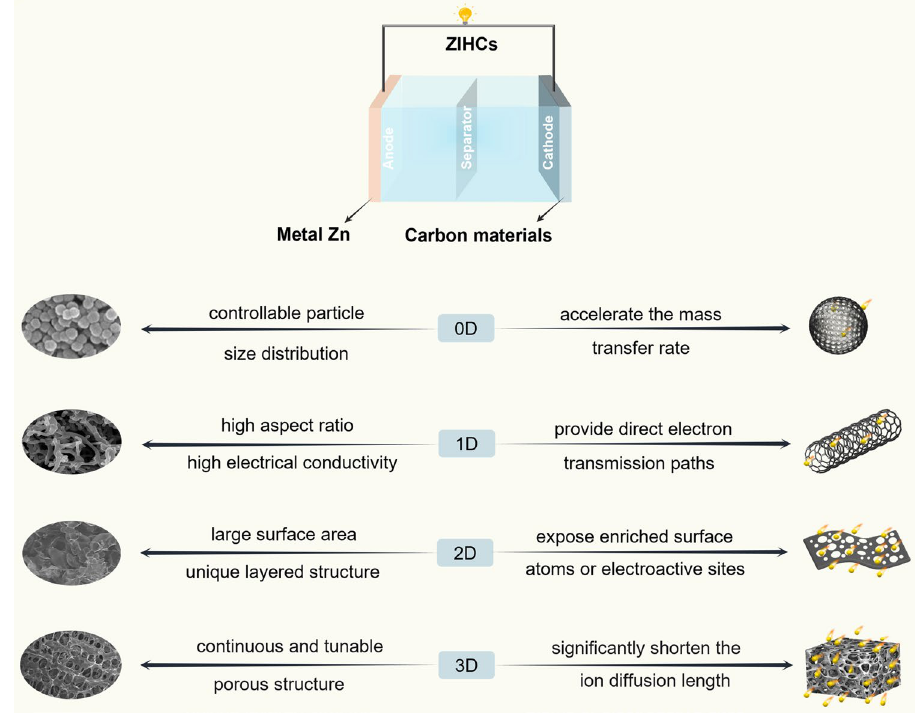
Fig. 4 Overview of carbon-based cathode materials with different dimensions for